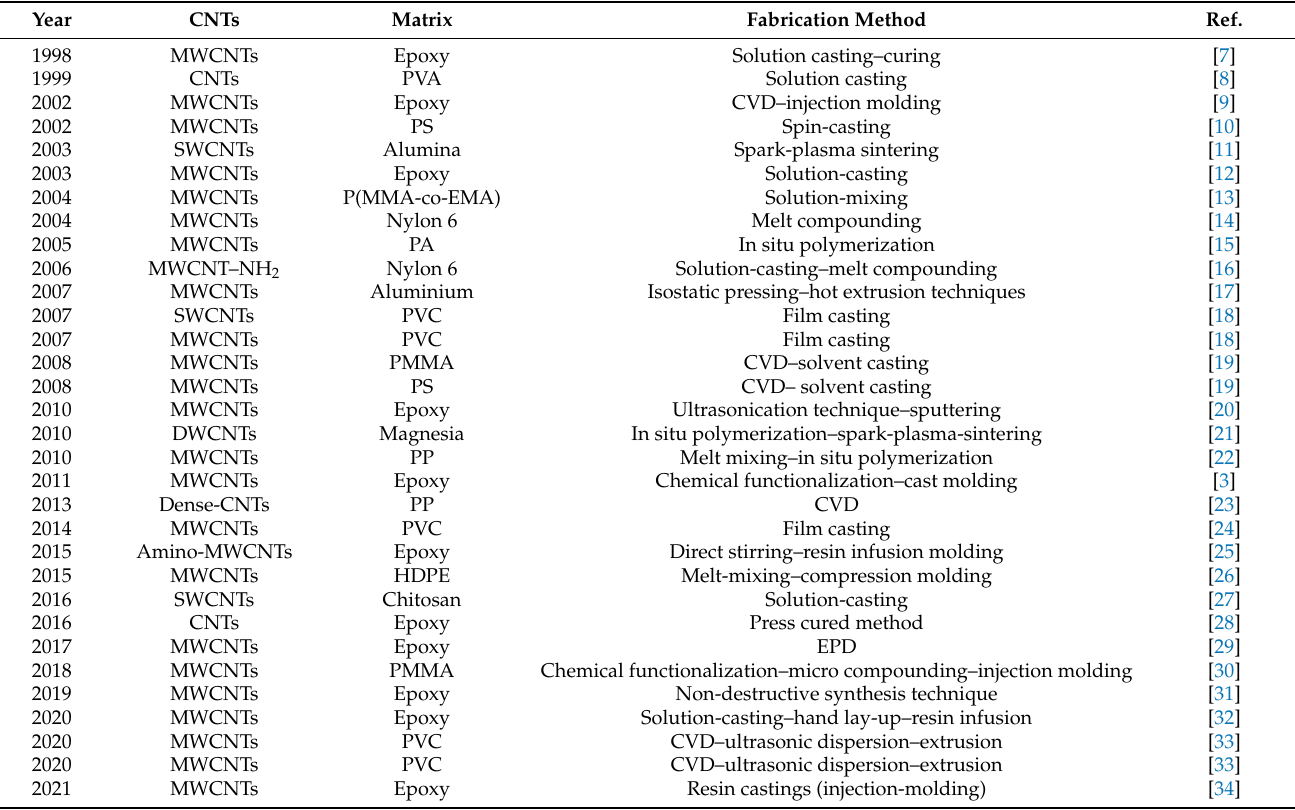
Table 1. Shows several examples of CNTs reinforced polymer composites made in the 1980s, organised by fabrication method. Matrix Fabrication Method